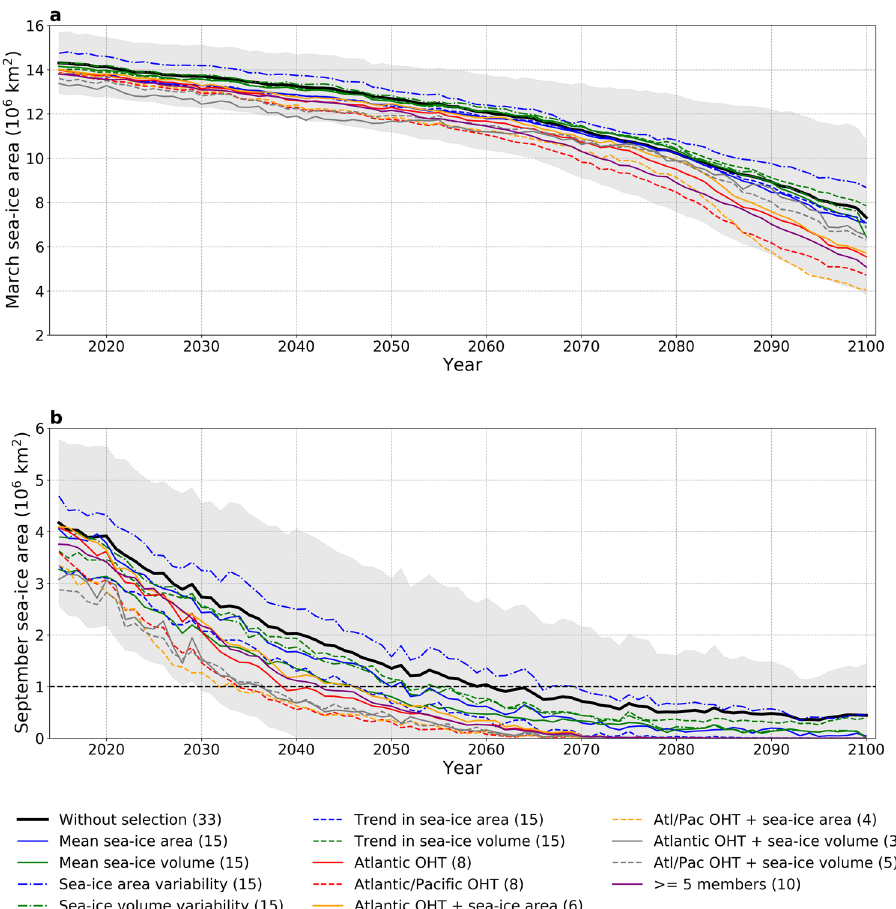
Fig. 2 Time evolution of future Arctic sea-ice area according to different selection criteria. Time evolution is provided for the CMIP6 multi-model mean averaged over all models (thick black curve) and averaged over the models selected according to different criteria (coloured curves). a March and ( b ) September Arctic sea-ice area based on the SSP5-8.5 scenario. The light grey shading shows the standard deviation around the multi-model mean without selection. The number of models included in each multi-model average is indicated in parenthesis in the legend. The horizontal dashed line represents the ice-free Arctic